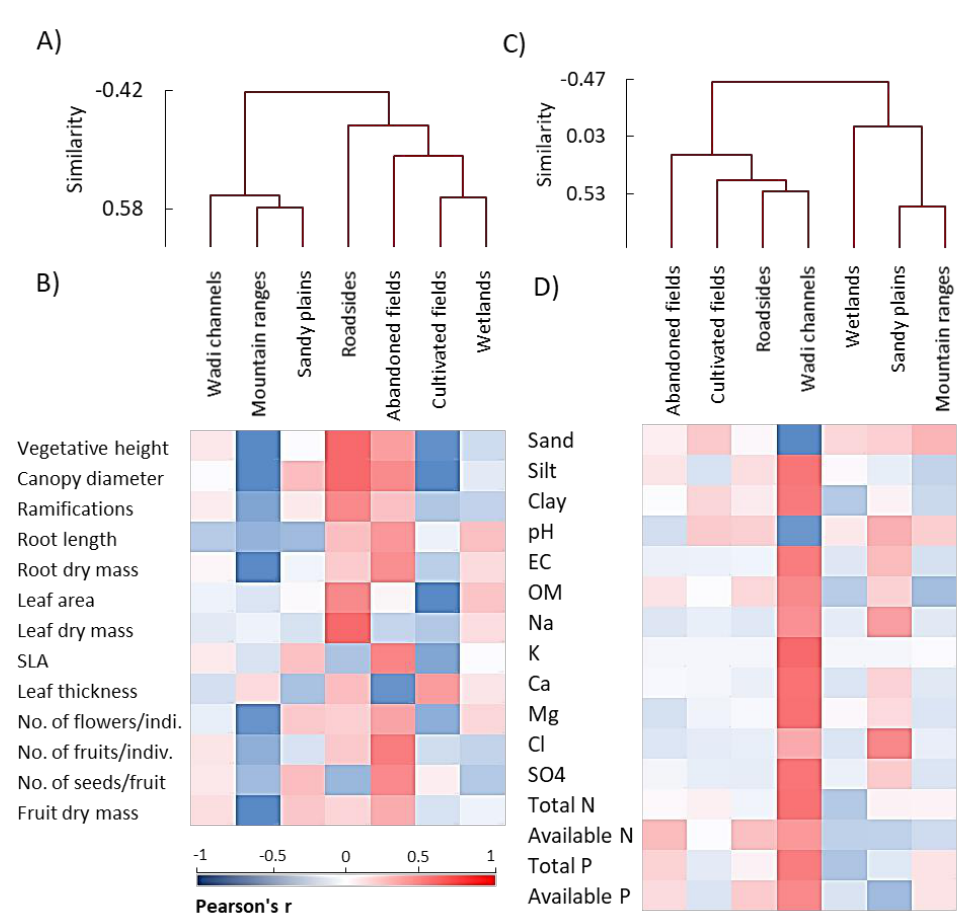
Figure 5. Agglomerative hierarchical clustering (AHC) and heatmaps of the studied parameters within different habitats of Argemone ochroleuca . ( A ) AHC and ( B ) heatmap based on the functional traits, ( C ) AHC and ( D ) heatmap based on the soil variables. EC: electrical conductivity, OM: organic matter, SLA: specific leaf area.